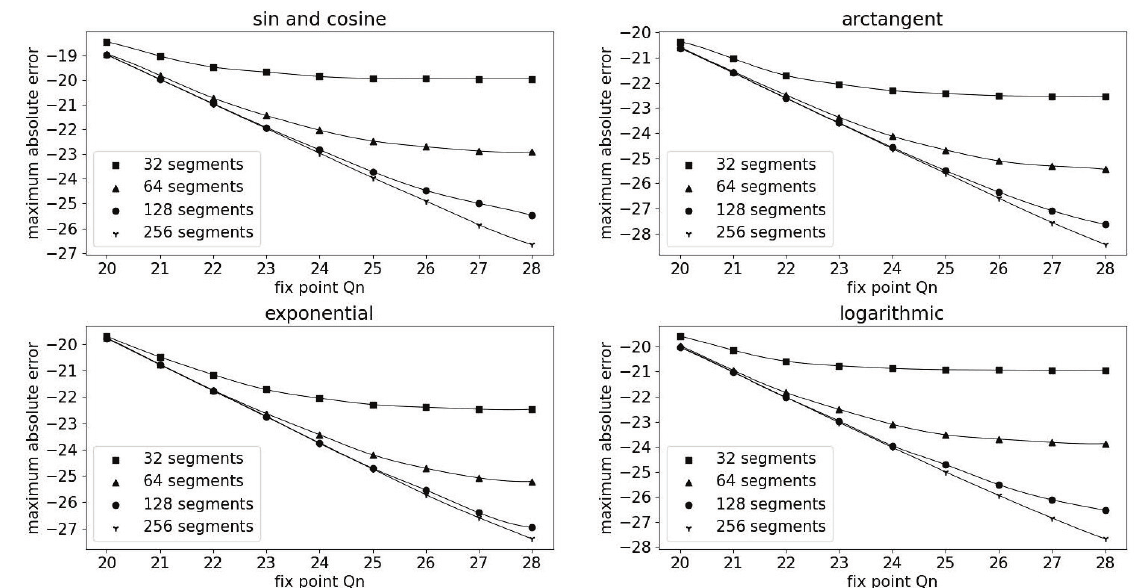
Figure 3. The relationship between the maximum error and the number of segments, the fixed- point parameter.